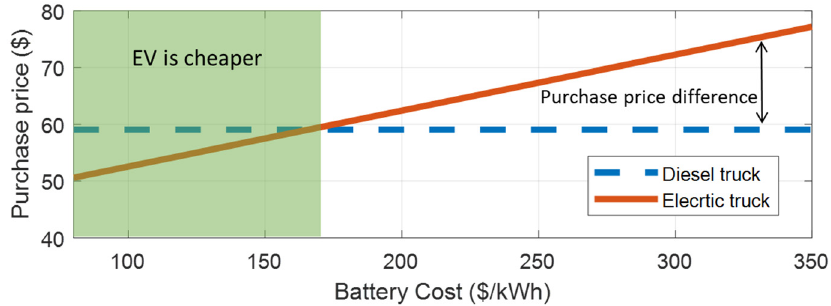
9 of 11 Figure 7. TCO parity check for class4 delivery truck with reduced VMT and resized battery pack. If a delivery truck is designed for 75 mile range and driven 75 miles every day, it would have TCO parity with a diesel truck even if the battery cost is $300/kWh, if the recharging of battery could be achieved at 10–12 cents per kWh. 6.2. Impact of Shorter Service Period This study assumes a service period of 15 years for medium-duty trucks. While it is